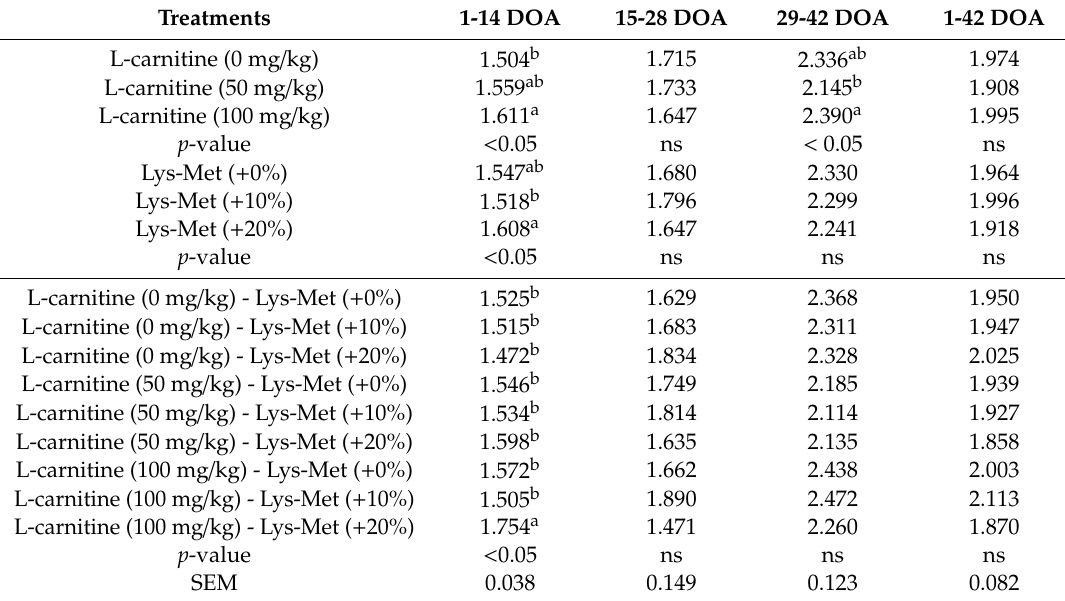
Table 5. Feed conversion ratio (g / g) of broilers fed di ff erent levels of L-carnitine and lysine-methionine (Lys-Met).